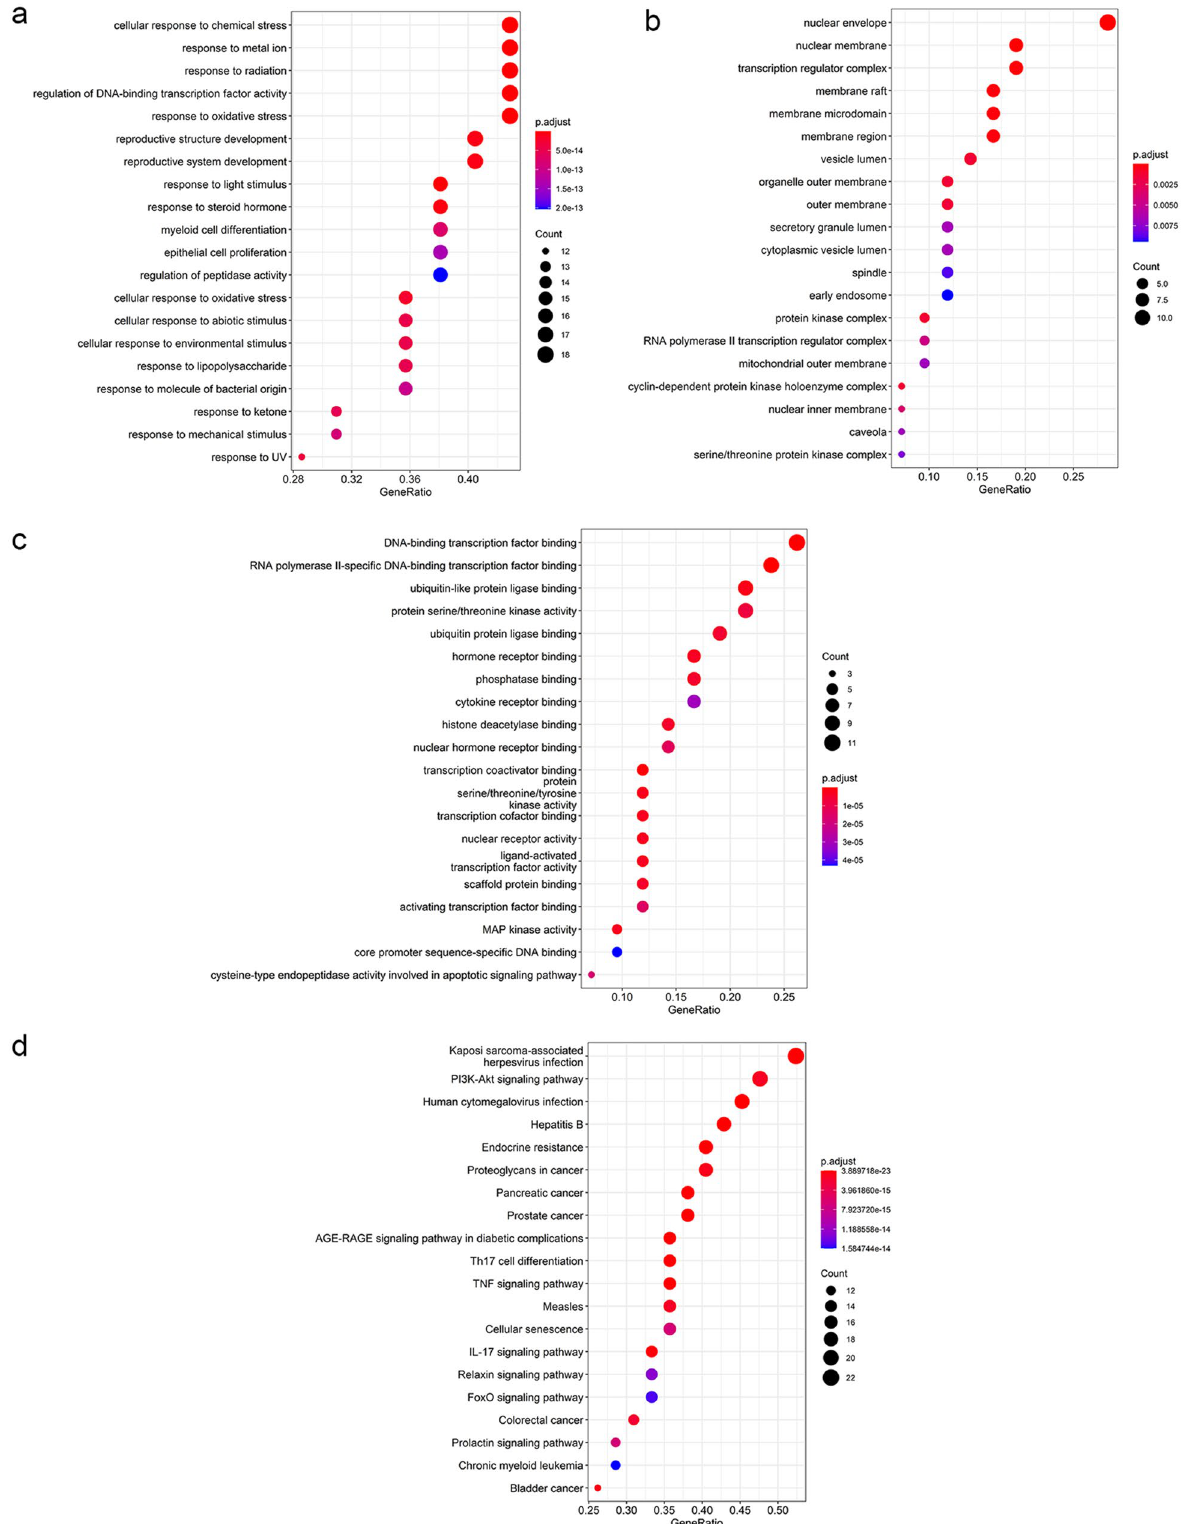
Figure 6. GO and KEGG pathway enrichment analyses of cluster 1 (p-value ≤ 0.05). ( a ) The top 20 biological processes for cluster 1. ( b ) The top 20 cellular components for cluster 1. ( c ) The top 20 molecular functions for cluster 1. ( d ) The top 20 KEGG pathways for cluster 1. The color scales indicate the different thresholds for the p-values, and the sizes of the dots represent the number of genes corresponding to each